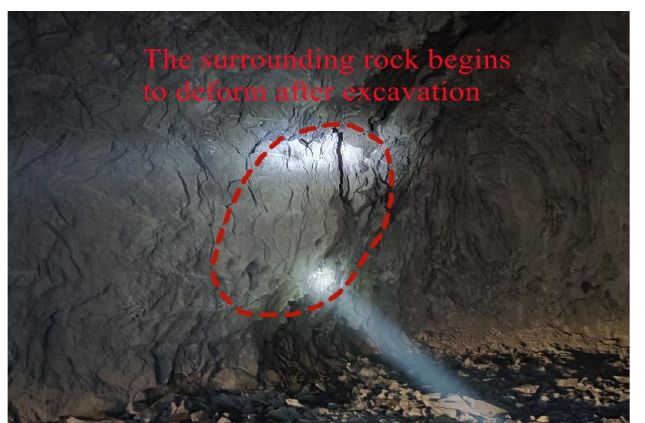
Figure 11. Deformation and failure of the surrounding rock on the left side of the tunnel